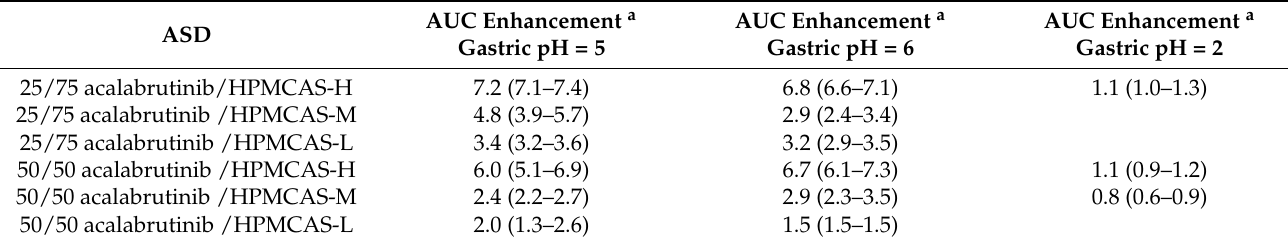
Table A10. AUC enhancements for ASD intermediates tested in gastric to intestinal transfer dissolution tests using a Pion µ Diss